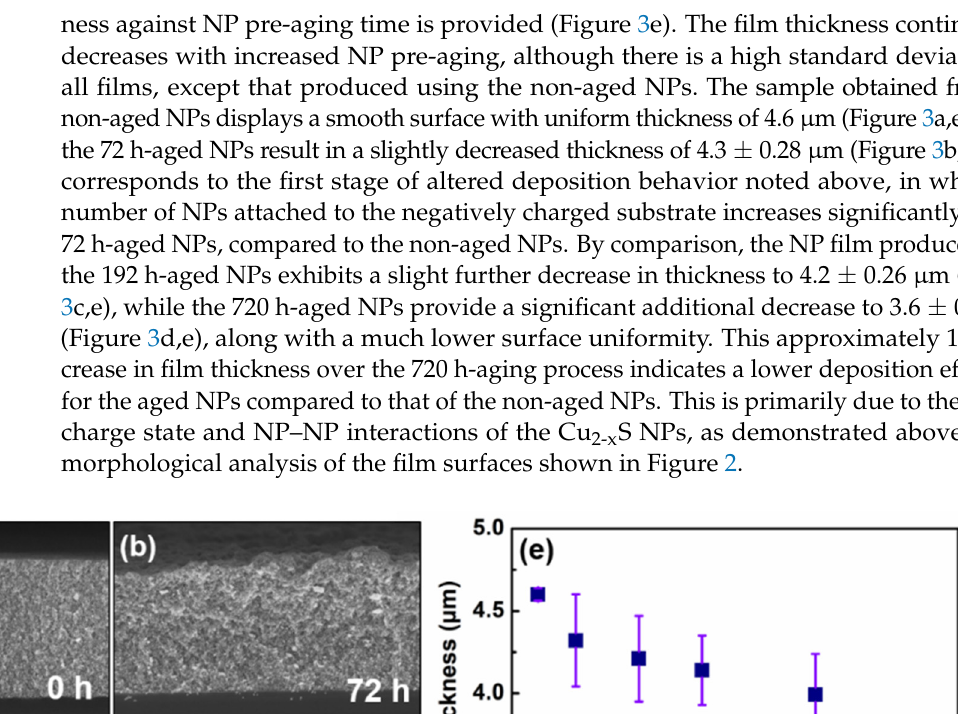
Figure 3. Cross-sectional SEM images ( a – d ) and dependence of film-thickness against pre-aging time ( e ) for films deposited on the positively charged substrate using variously-aged NPs.